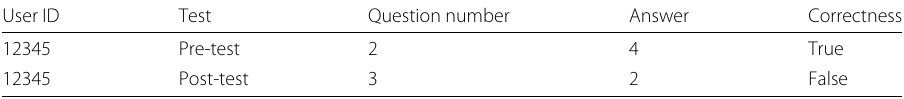
Table 3 The format of the log data for test answers in the